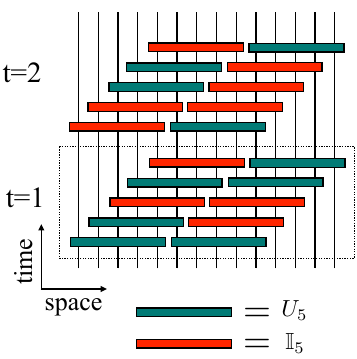
Figure 2: The local random QA circuit with 5-qubit gate. A single period of the circuit consists 5-layers. The block is a 5-qubit gate which randomly picks an identity operator or U gate with equal probability. The dashed box indicates the circuit in 5 one time step.